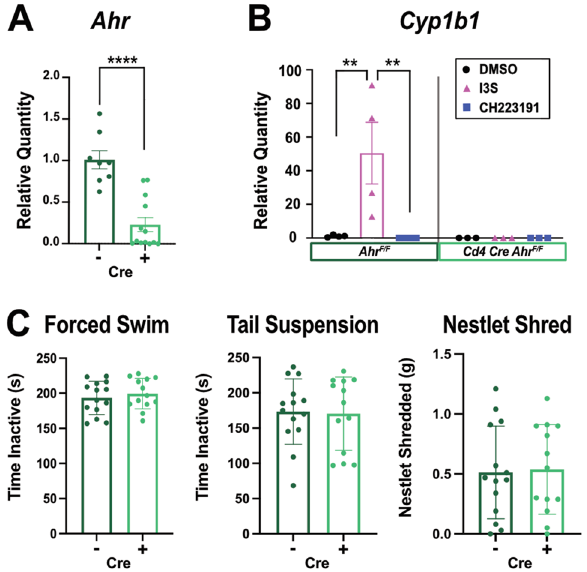
Figure 1. Absence of Ahr in T cells does not Influence Baseline Behavior. ( A ) Relative quantity of Ahr expression from in vitro skewed Th17 cells in Ahr KO and Ahr competent cells was determined by qPCR (n = 8 or 13/group). T test ( p = < 0.0001). ( B ) Relative quantity of Cyp1b1 expression from Ahr KO and competent cells skewed in vitro to become Th17s and treated with an Ahr agonist (I3S), antagonist (CH223191), or control media (DMSO) (n = 3–4/group). Combined N = 2. Two-way ANOVA (DMSO to I3S: p = 0.0019; I3s to CH223191: p = 0.0016, interaction statistics in Supplemental Table 1). ( C ) Baseline behavioral